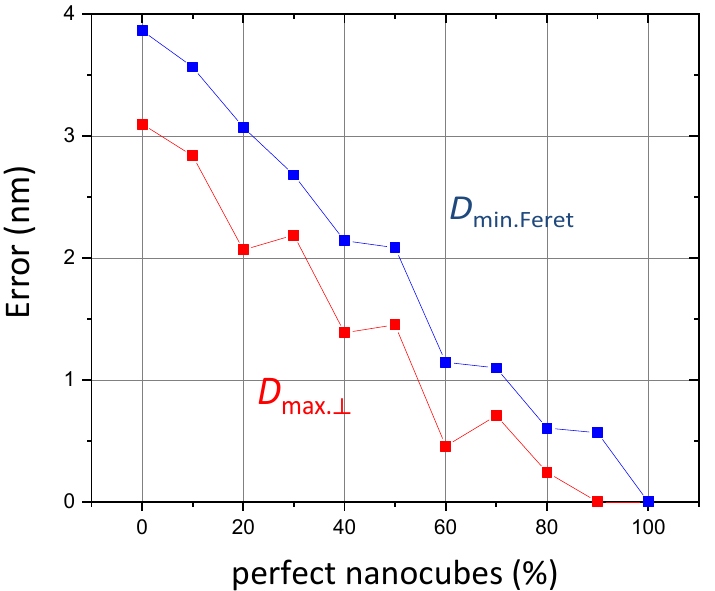
Figure 13. Expected error calculated by random draw analysis for different fractions of perfect/imperfect nanocubes.